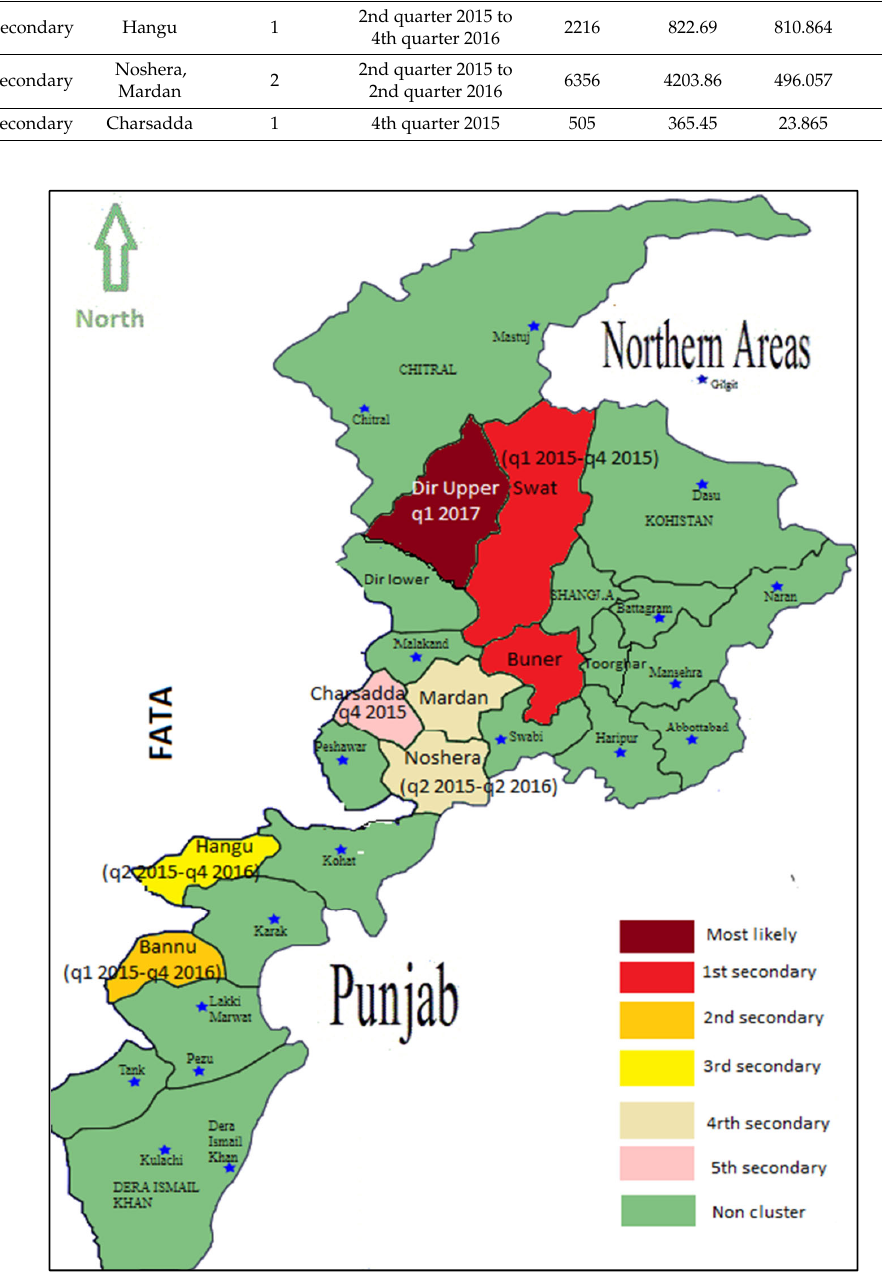
Figure 2. The locations of space ‐ time clusters in the study area.